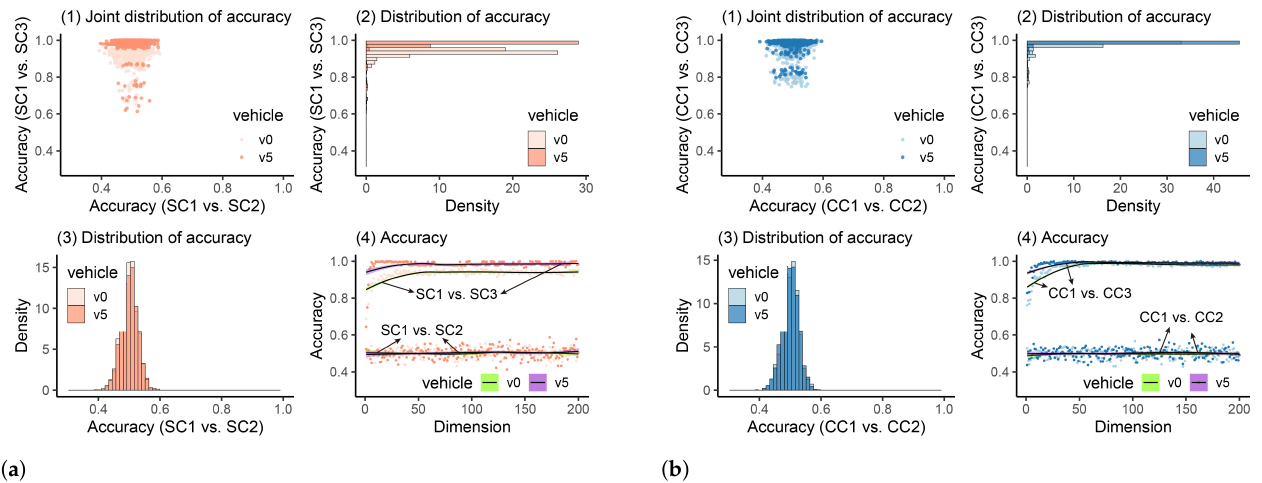
Figure 18. Classification accuracy values using MFCCs. ( a ) Classification accuracy values using the SSB model. ( b ) Classification accuracy values using the CSB